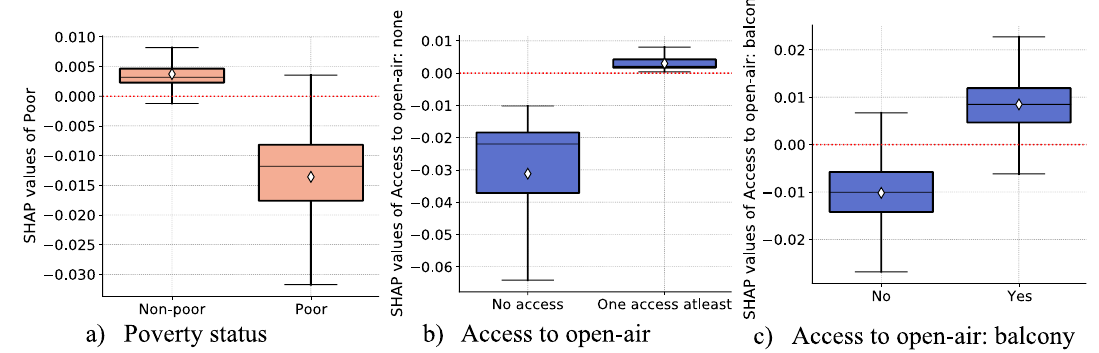
Figure 4. Partial effects of income and housing features. Notes : Each panel ( a )–( c ) display SHAP dependence boxplots of income and housing features. The diamond symbol in the boxes denotes the average of SHAP value distribution per each